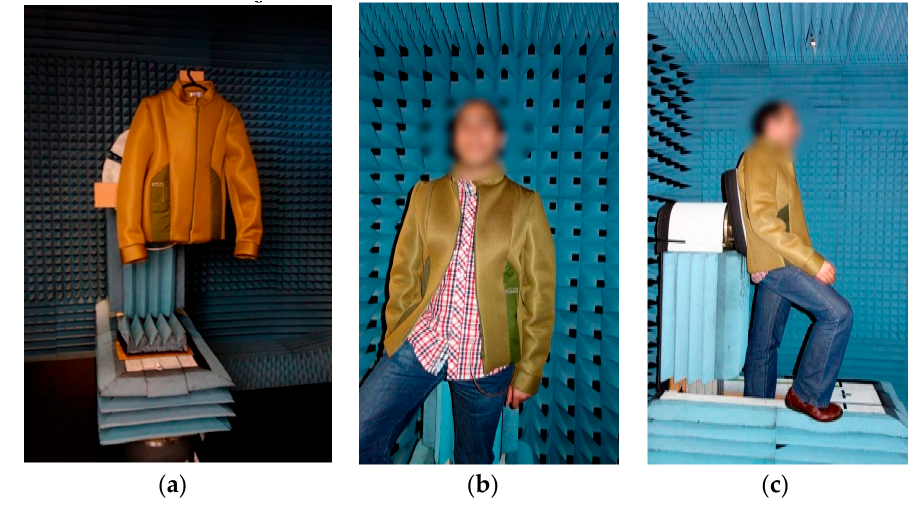
Figure 9. Performance of the antenna in the anechoic chamber ( a ) in free space and ( b , c ) on-body measurements.